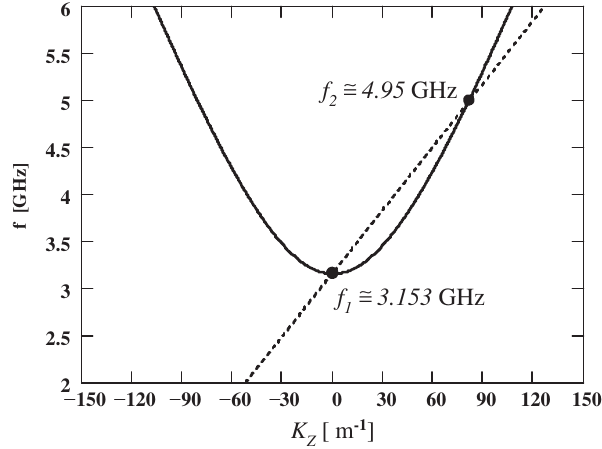
FIG. 2. The electron beam line (dashed) and the TE 10 mode dispersion curve (solid) (for parameters as per Table